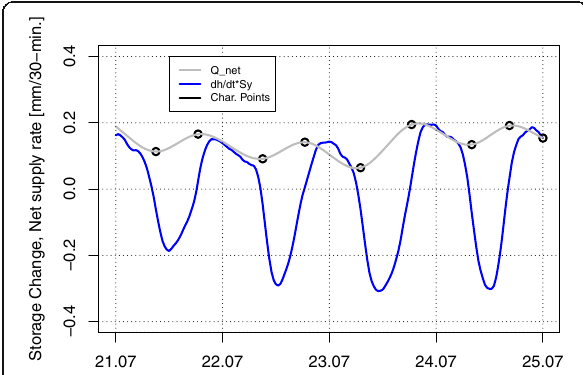
Fig. 3 Graphical representation of the method for ET gw calculation. The blue line is the time derivative of groundwater level multiplied by specific yield ( ∂ h/ ∂ t* S y ) representing storage change. Dots are characteristic points; the grey line represents net supply rate ( Q net